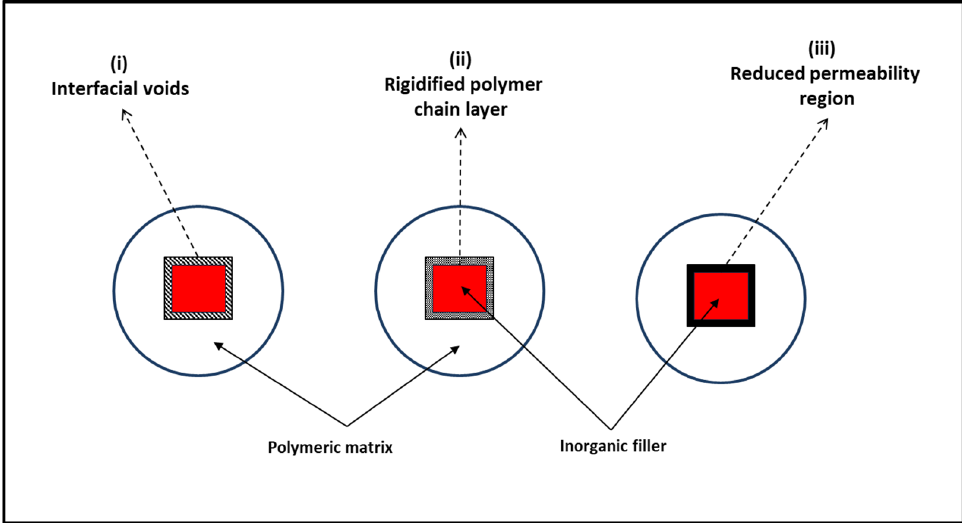
Figure 11. Schematic diagram of an interface void ( i ), rigidified polymer ( ii ) and partial blockage ( iii ) in MMMs. (Adapted from Aroon and co-workers, 2010).